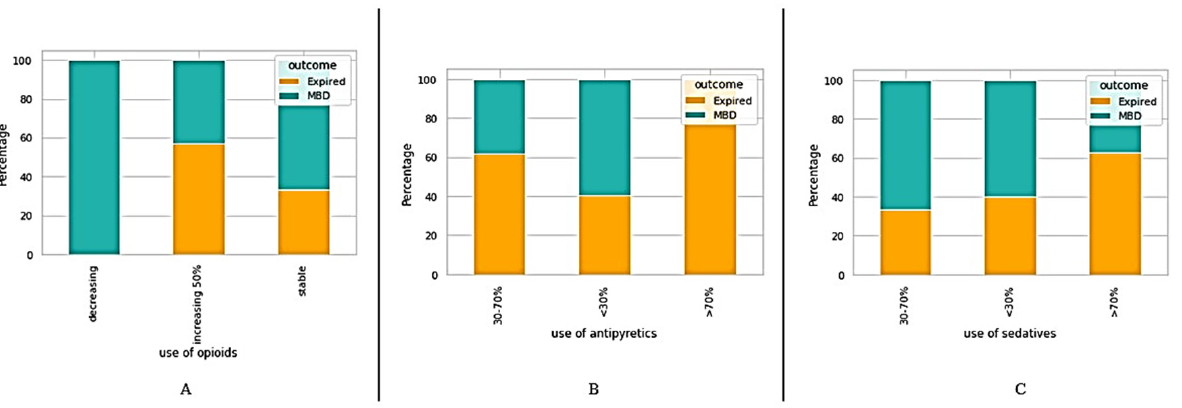
Figure 2. Classification of patients on the basis of medications—( A ) Opioids ( B ) Antipyretics ( C ) Sedatives.